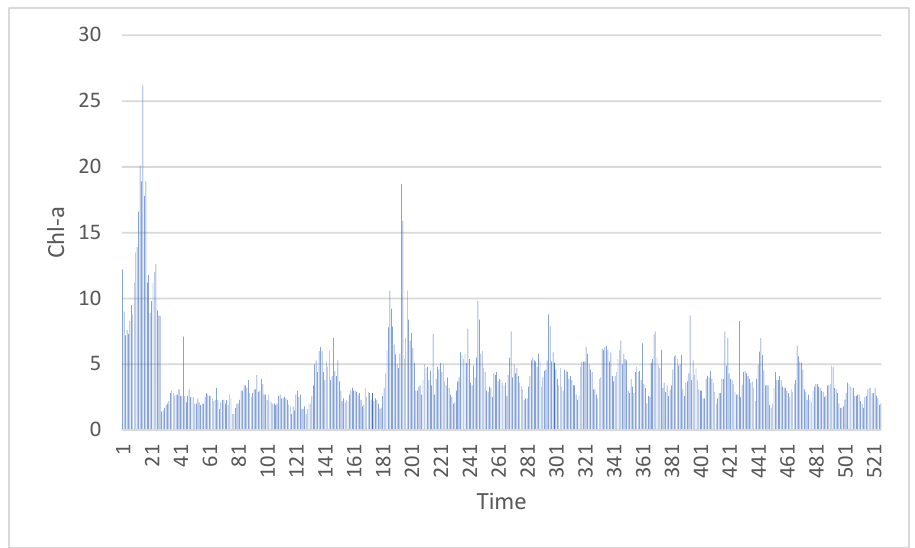
Figure 4. The Chl-a value and its fluctuations.